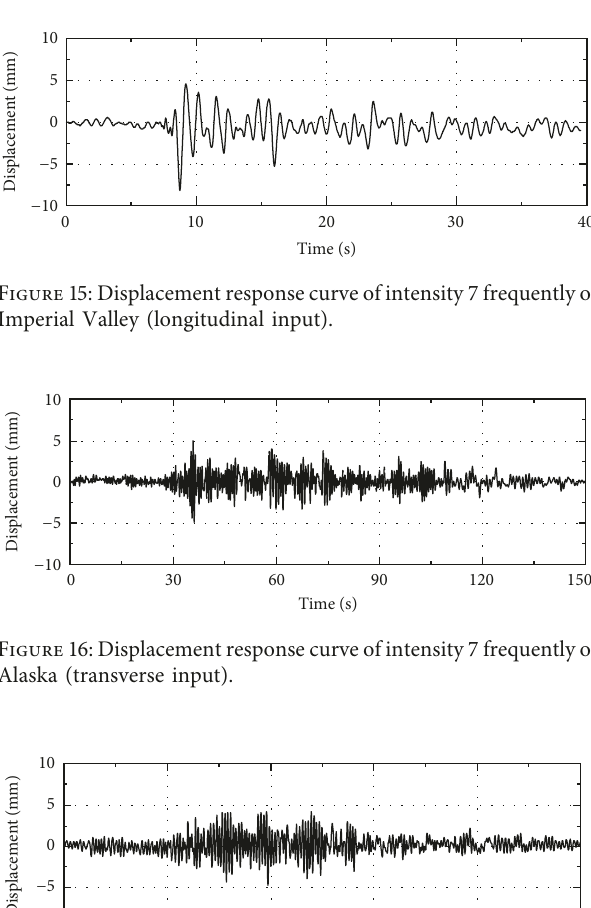
Figure 10: Earthquake acceleration time-history curve of intensity 7 fortification of synthesized (longitudinal input).